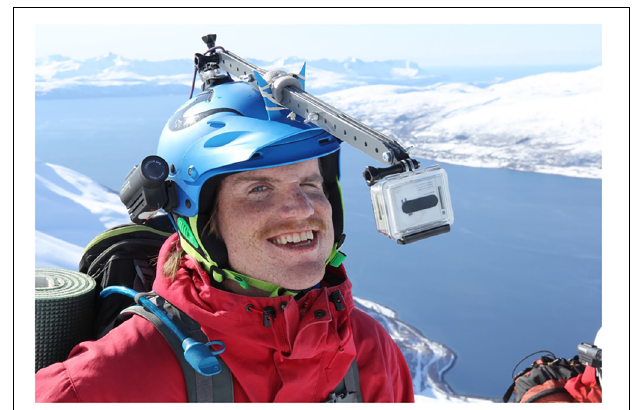
FIGURE 1 | The helmet and cameras used for collecting data. Written informed consent has been obtained from the participant for the publication of this